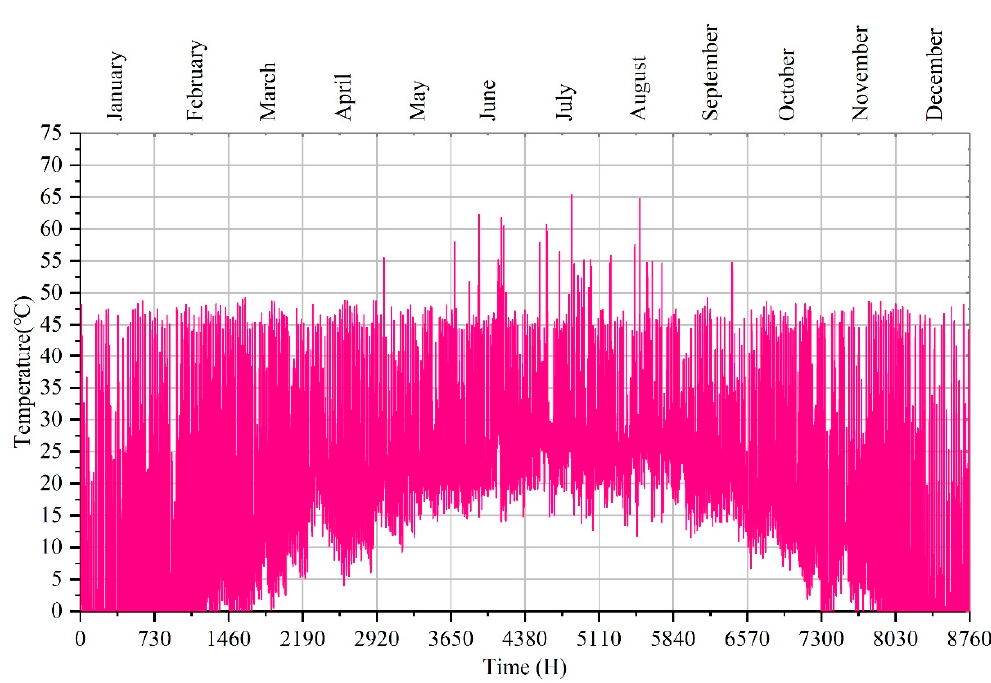
Figure 10. Outlet temperature changes of the LCPV/T model during a year.